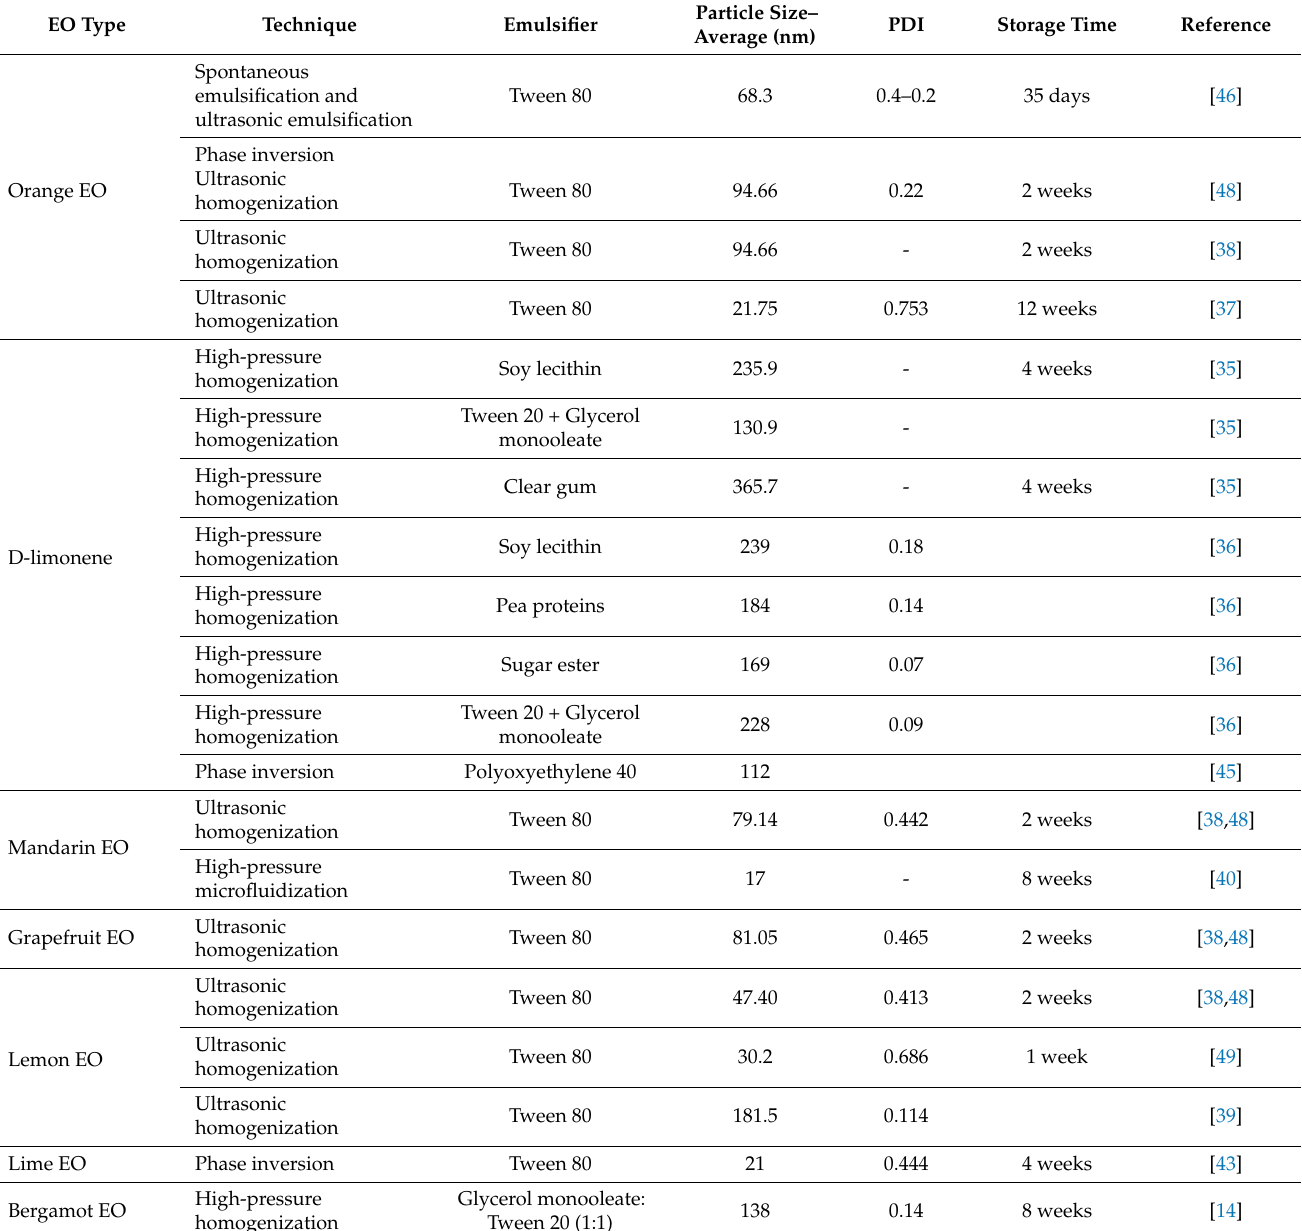
Table 1 summarizes the types of methods and emulsifiers used for different EOs NEs and also the results regarding the droplet sizes and PDI. The literature reports heterogenous data for the particle size, even for the same EO, in accordance with the technique and emulsifier used in the process. As revealed by the data presented, high-energy techniques have more popularity compared to low-energy techniques. Table 1. Comparison of physical–chemical properties for NEs produced with citrus essential oils and different types of